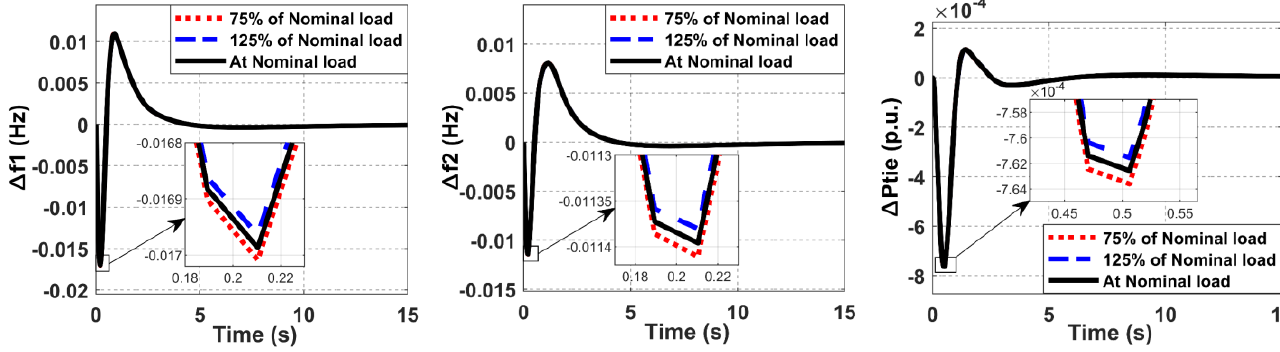
Figure 17. The dynamic response of the power system under different system loading ( ± 25% of the nominal load).